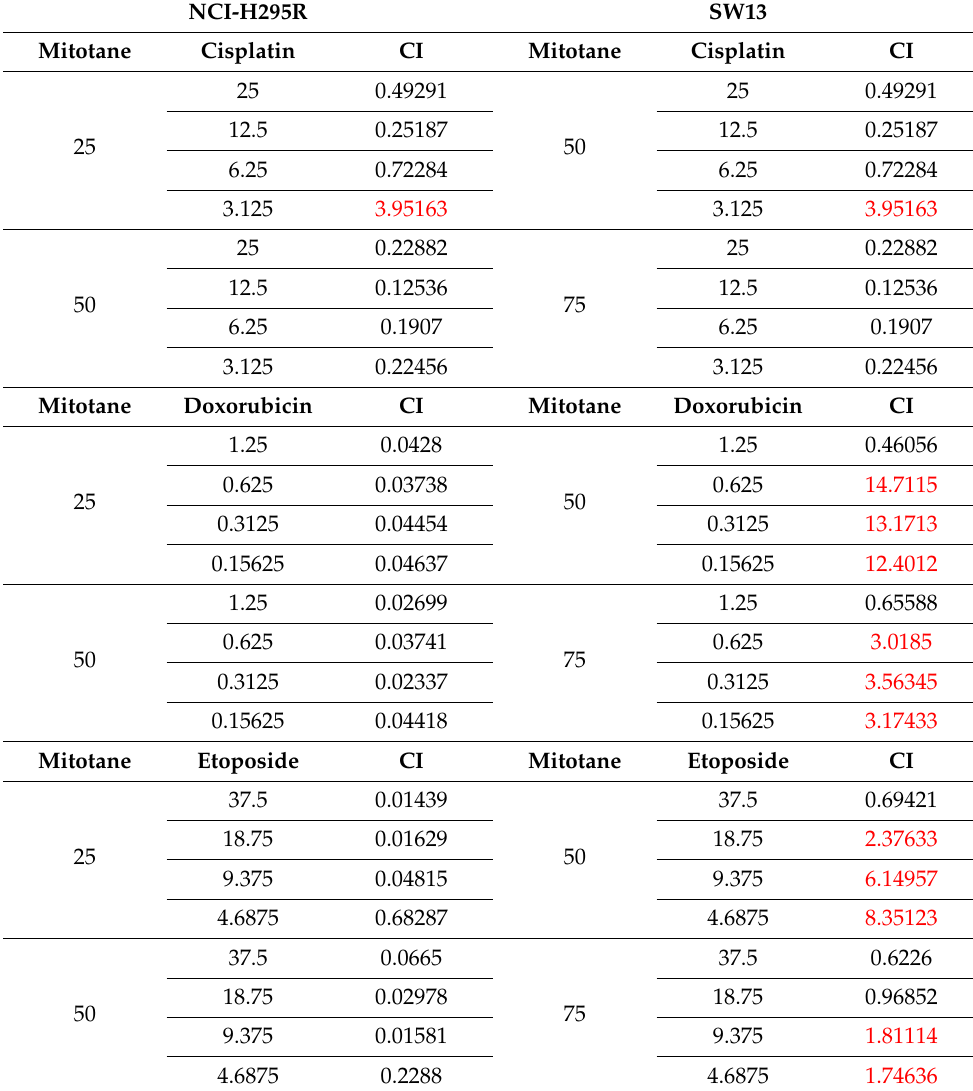
Table 1. ACC cell lines NCI-H295R (Left) and SW13 (Right) were treated with varying concentrations of chemotherapeutics with or without mitotane for 72 h and the combination Index was calculated using Chou-Talalay equation. C < 1 is synergistic, C = 1 additive, and C > 1 is antagonistic (Red text). NCI-H295R